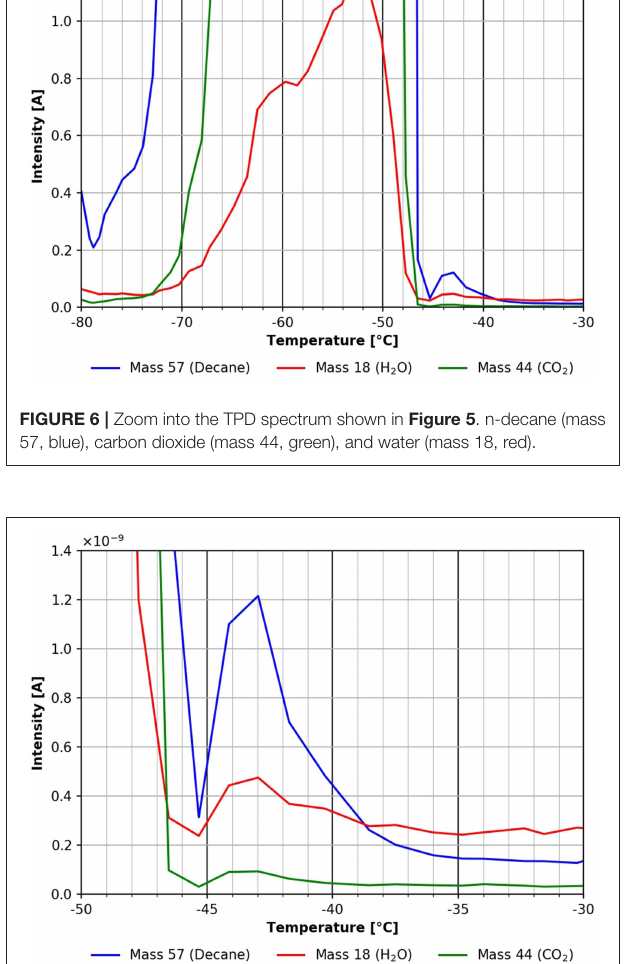
of CO 2 and water is clearly visible in Figure 7 still, indicating that these species find similar adsorption sites on the cellulose surface.